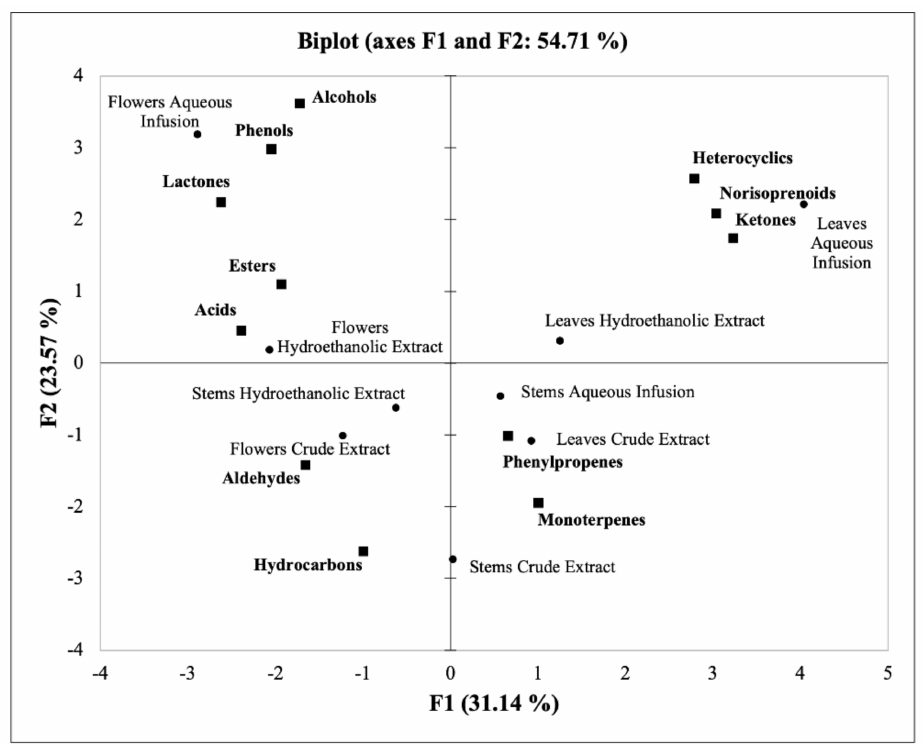
Figure 4. Principal component analysis (PCA) of all classes of organic volatile compounds (VOCs) (aldehydes, alcohols, ketones, esters, acids, monoterpenes, norisoprenoids, hydrocarbons, lactones, phenols, and phenylpropenes) identified in the Prunus avium L. stem, leaf, and flower extracts (hydroethanolic, aqueous infusion, and crude) in the plane composed by the principal axes F1 and F2 (54.71%). The samples are represented with a dot, and VOCs classes are represented with a square. According to Figure 4, it is possible to verify that the richest extracts in heterocyclics, norisoprenoids, ketones, phenylpropenes, and monoterpenes (all leaf extracts, and stem hydroethanolic extract) were mainly found in the positive F1 axis. On the other hand, the extracts that presented higher contents of aldehydes and hydrocarbons but the lowest levels of heterocyclics, norisoprenoids, and ketones were projected along the negative F1 and F2 axes (stem hydroethanolic extract and flower crude extract). Additionally, the extracts richest in alcohols, phenols, lactones, acids, and esters were found on the positive F2 axis (flower aqueous infusion and hydroethanolic